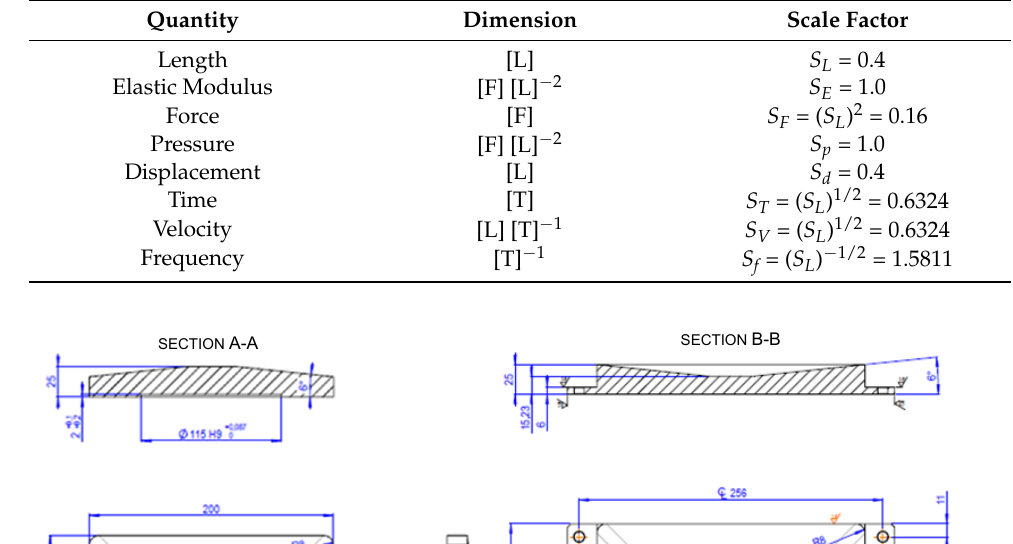
Table 1. Scale factors assumed for the tests.